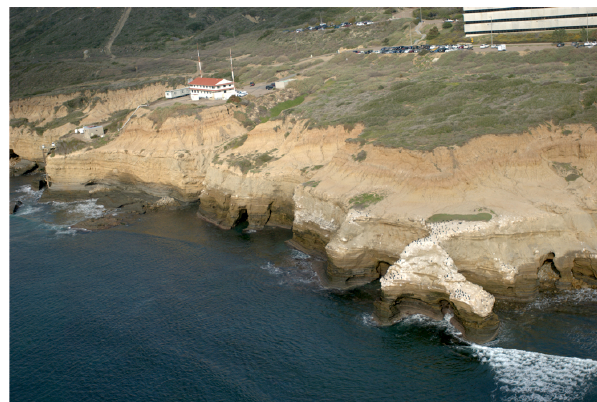
Fig. 2. Oblique photo showing the general stratigraphy and landscape of the study area (photo by Darren Wright, California Data Information Program).